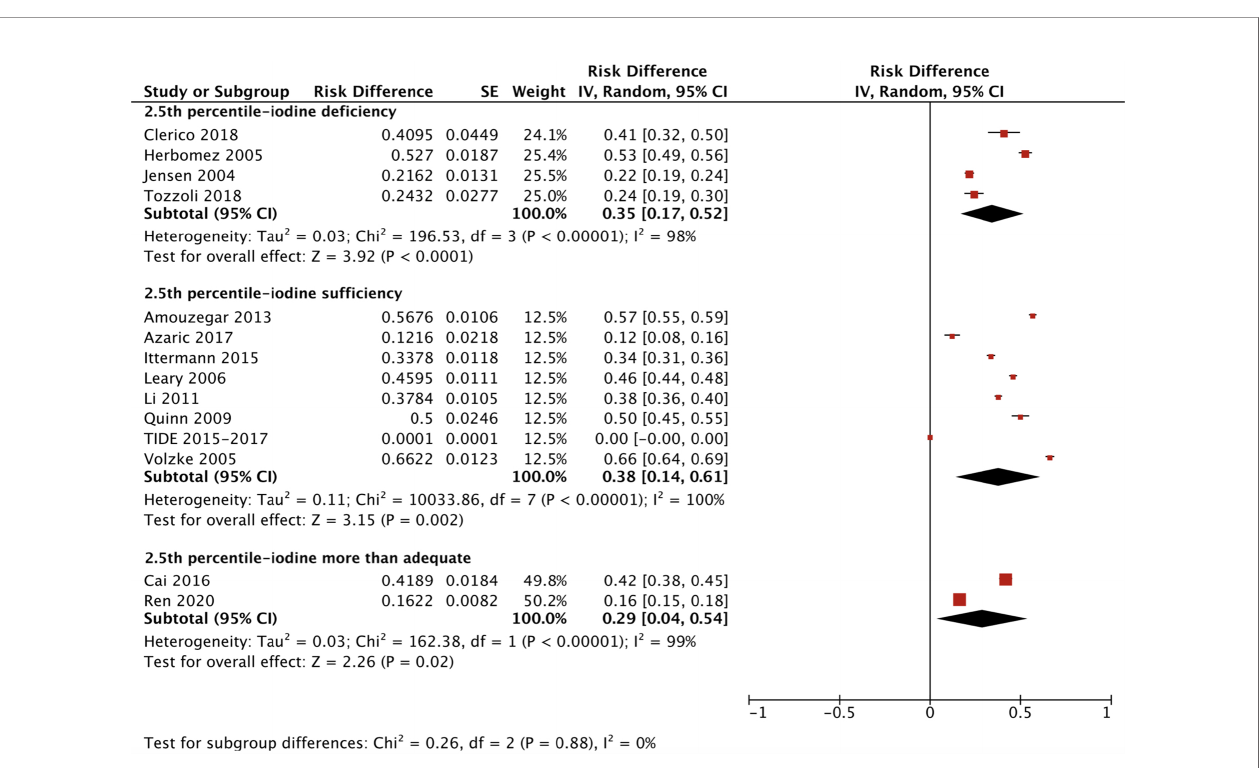
FIGURE 6 | Iodine status standardized forest plots of the pooled relative descent rate (%) of TSH lower limits (2.5 th percentile) in NACB